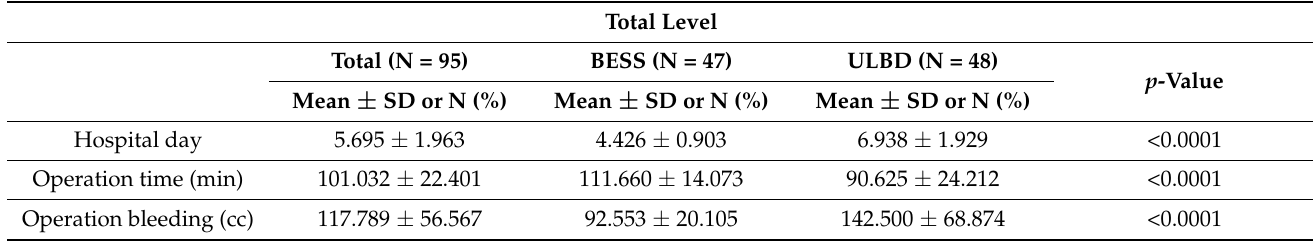
Table 2. Surgical outcome by range of surgical